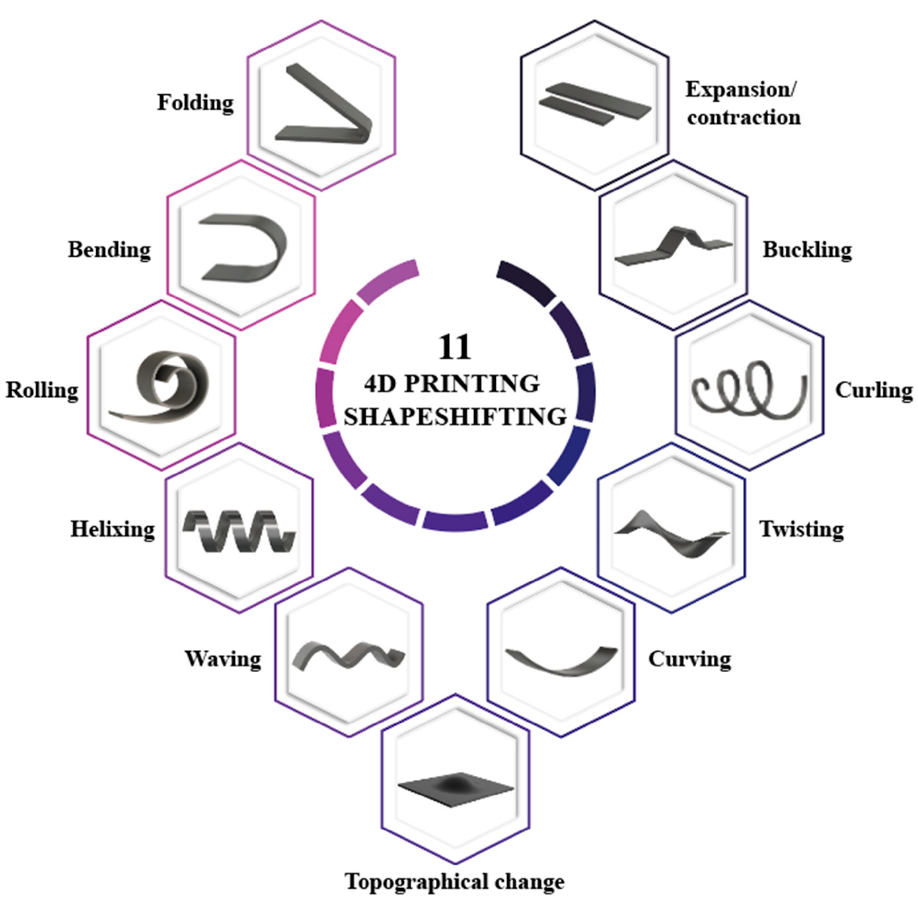
Figure 3. The 11 shape-changes behaviours of 4D Printing.